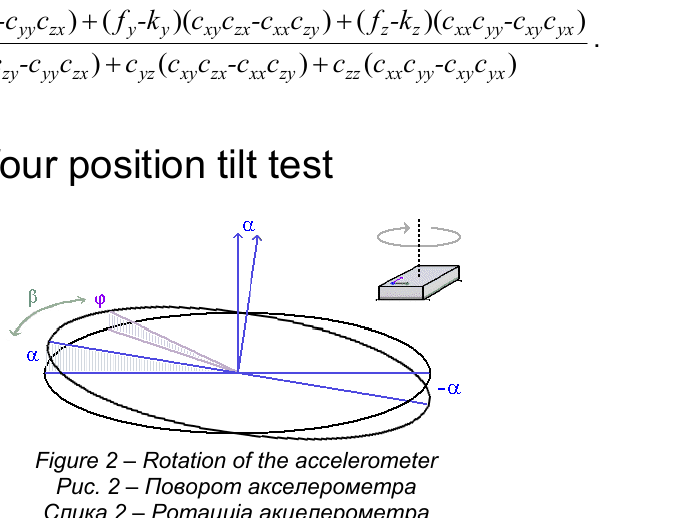
Figure 2 – Rotation of the accelerometer Рис . 2 – Поворот акселерометра Слика 2 – Ротација